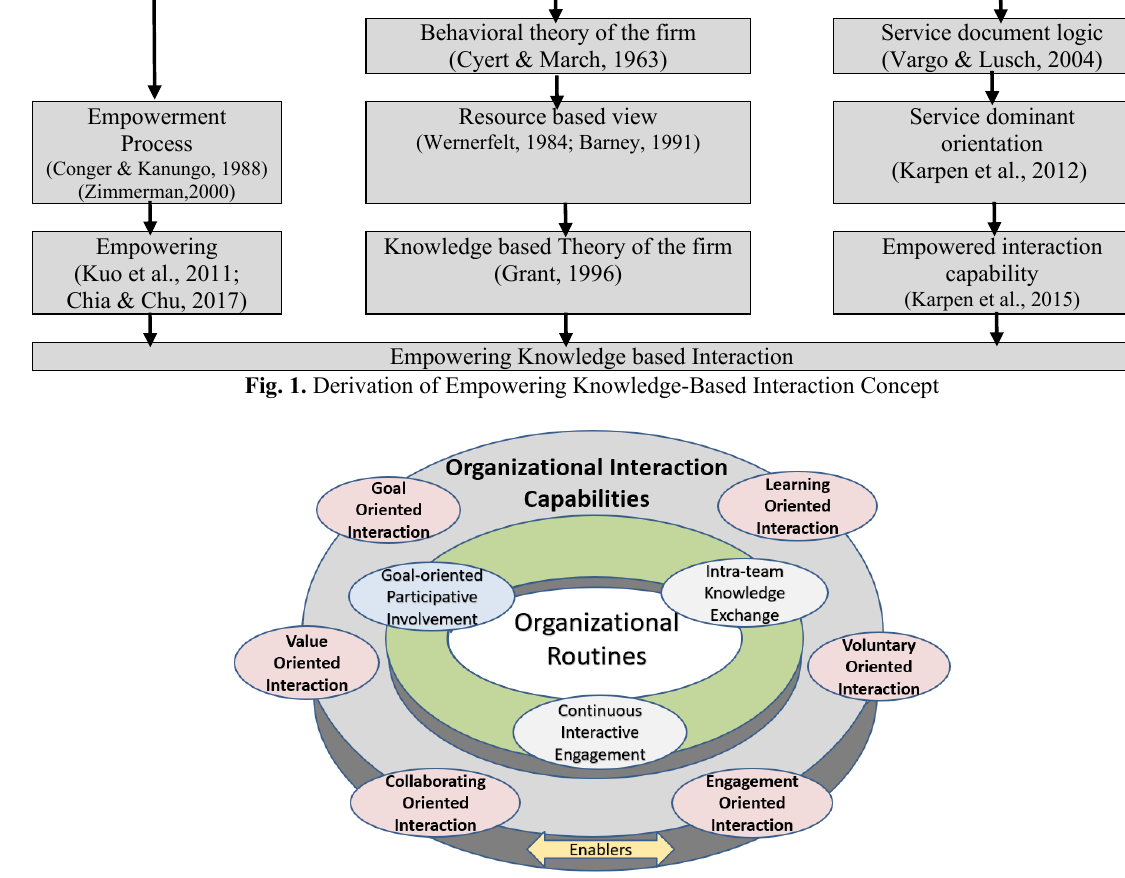
Fig. 2. Empowering Knowledge-Based Interaction